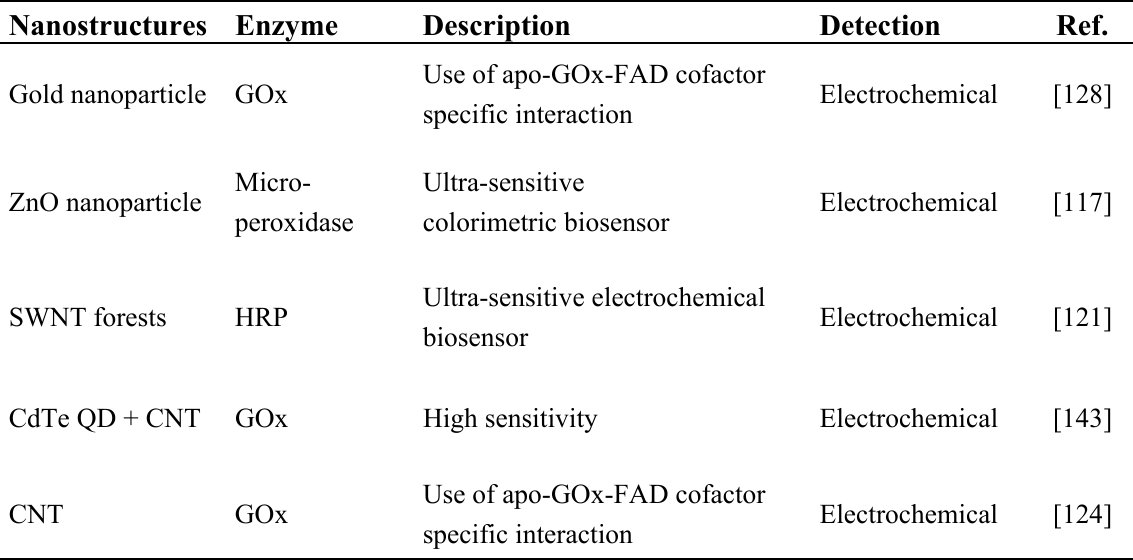
Table 6. Detection of enzyme reaction at the